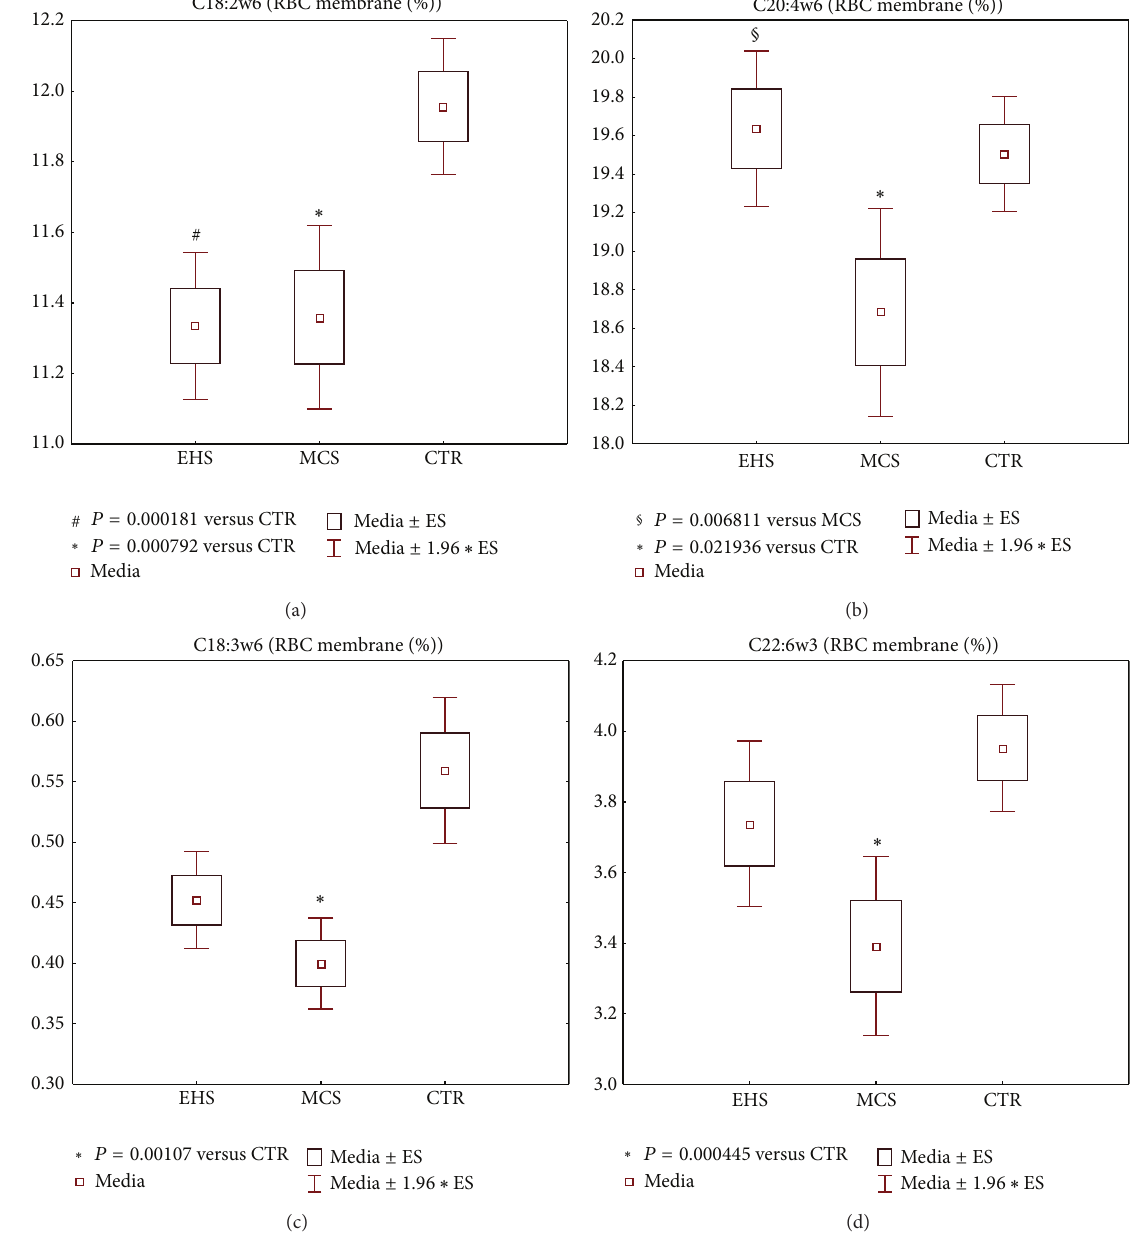
Figure 8: Selected representative omega-6 and omega-3 polyunsaturated fatty acids (PUFA) of erythrocytes membrane phospholipid fatty acids (FA), in the groups of patients self-reporting electromagnetic hypersensitivity (EHS, 𝑛 = 58 ), of patients affected by multiple chemical sensitivity without EHS symptoms (MCS, 𝑛 = 54 ), and of control healthy subjects (CTR, 𝑛 = 70 ). (a) % C18:2 𝜔 6; (b) C20:4 𝜔 6; (c) C18:3 𝜔 6; (d) C22:6 𝜔 3 FAs, on total FA content of phospholipids. Values are represented as mean ( ◻ ), standard error of the mean (upper and lower limits of the box), and 1.96 × standard error (upper and lower whiskers). Intergroup significant differences ( P ) are reported under each